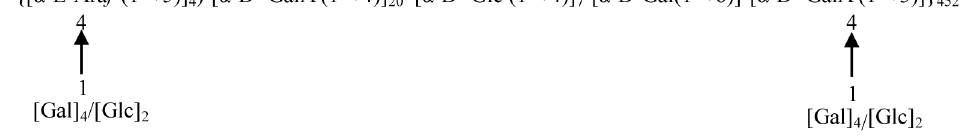
Figure 5. Proposed repeating units of APS and molecular